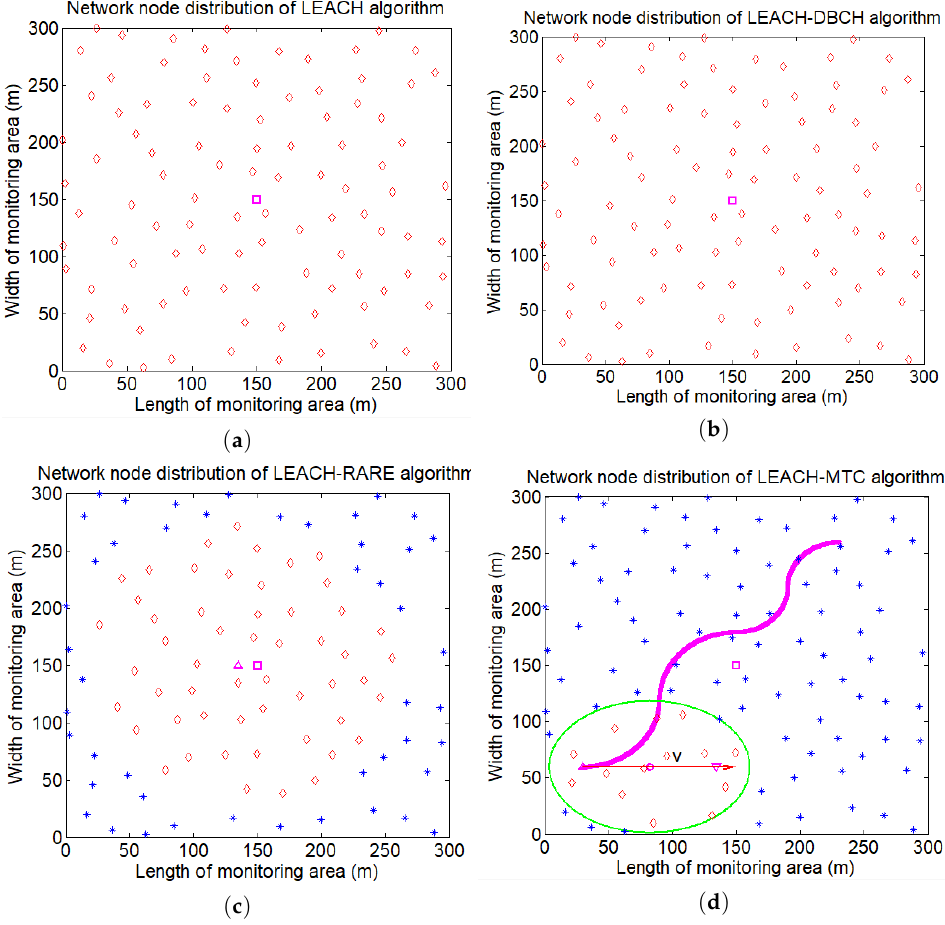
Figure 4. Node distribution of four